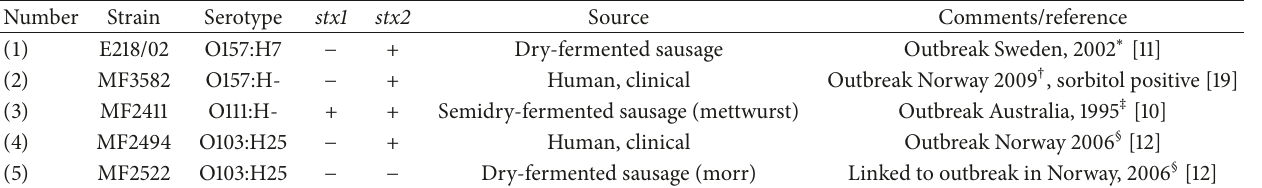
Table 1: E. coli isolates used in this